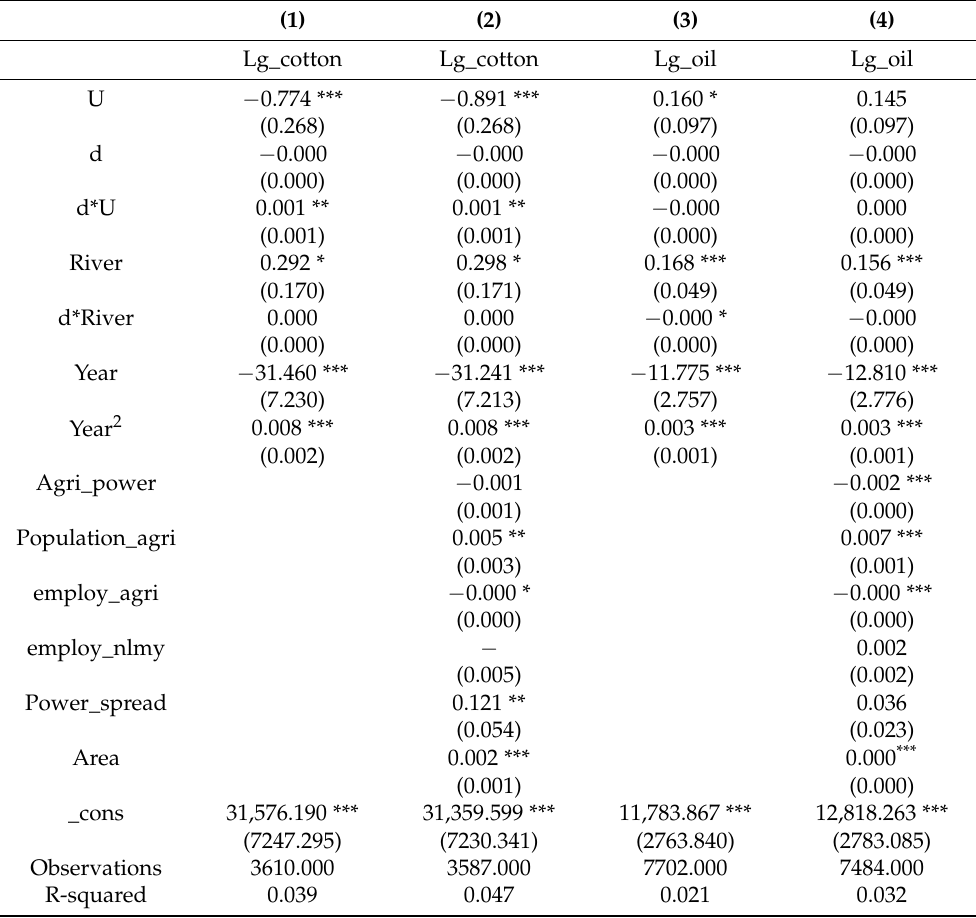
Table 7. Baseline results—the agricultural impact of building the